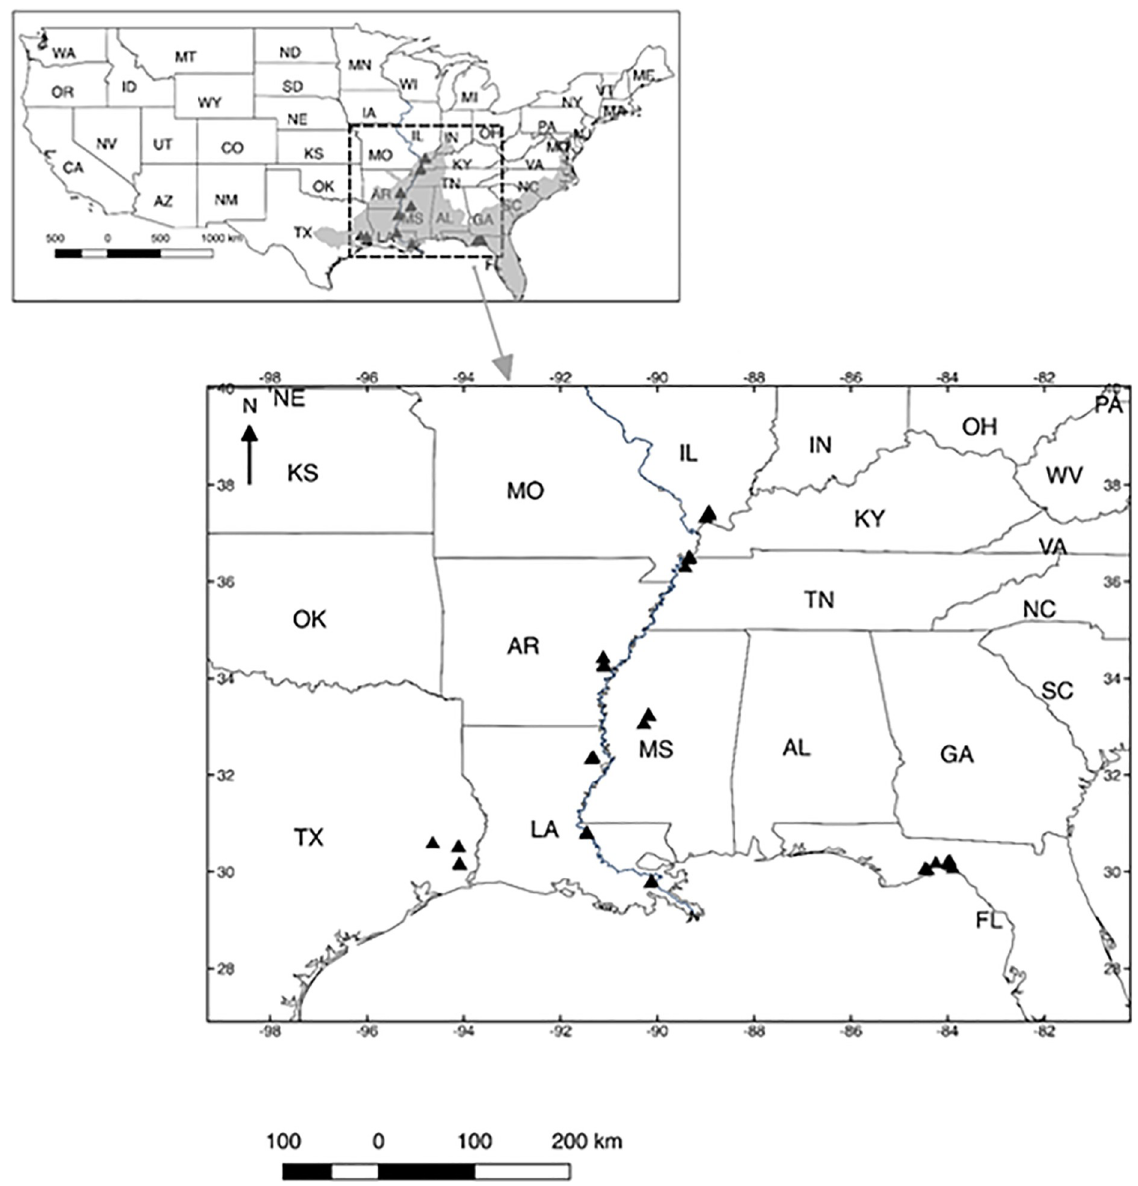
Fig 2. North American Baldcypress Swamp Network location in the southeastern United States (gray shading depicts the range of T . distichum var. distichum [71]. These freshwater forested swamps lie along the Mississippi River Alluvial Valley (MRAV; inland swamps) and Gulf of Mexico Coast (tidal and nontidal), and are dominated by T . distichum . Each network site has five replicate swamps (triangles), with three-five sites selected for the leaf and wood litter decomposition and cloth-strip decomposition studies. Two sites were selected in swamps along the MRAV to examine percent soil organic matter. See S2 Table for details on network location and specific